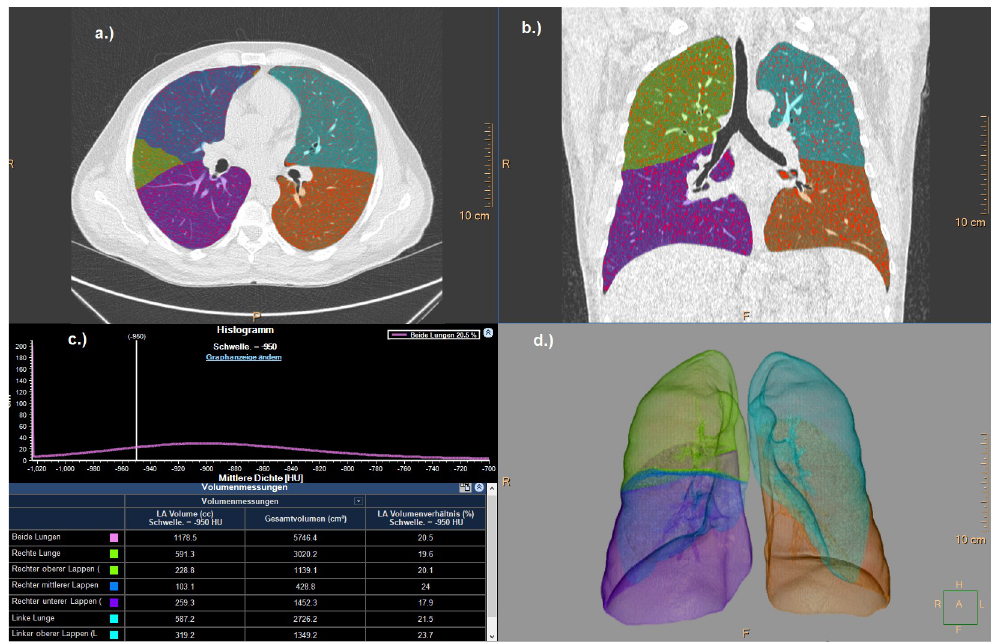
Fig 2. Automated lobe segmentation process and quantification of emphysema per lobe in a 45-year-old woman with COVID-19 pneumonia. (a./b./d.) Sequential segmentation of airways, lungs, and lobes. (c) Results of volumetric measurement of emphysema in both lungs, each lung, and each lobe (attenuation threshold of voxels, < -950 HU). Emphysematous voxels are shown in red. Reprinted under a CC BY license, with permission from Philips Healthcare, original copyright